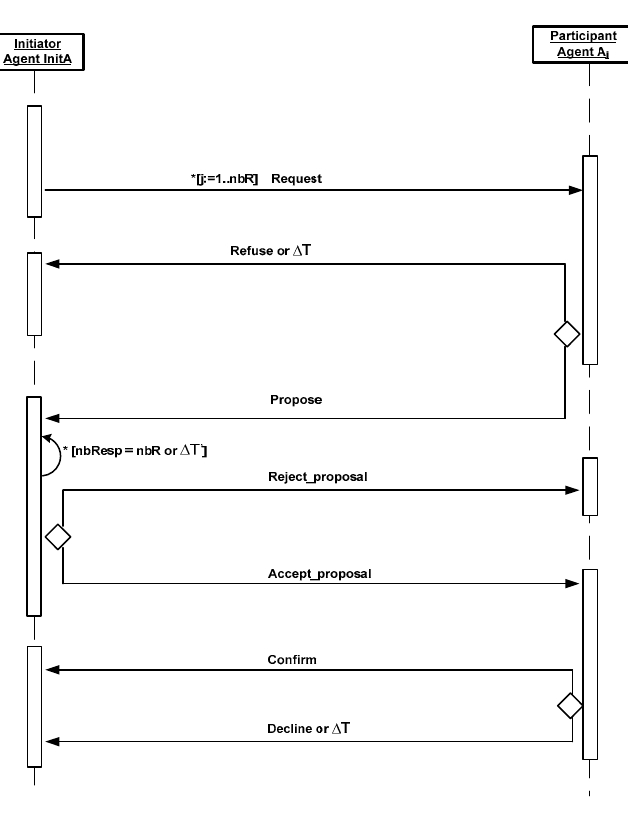
Figure 3. Distributed task allocation approach.